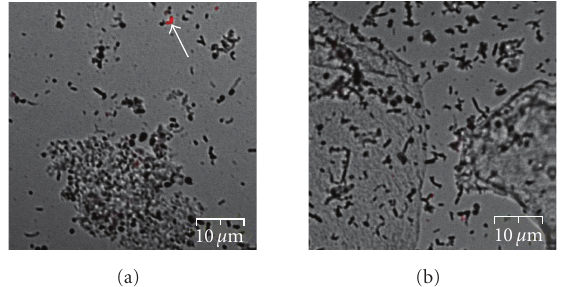
Figure 6: Detection of M. tuberculosis in spiked sputum. M. tuber- culosis spiked sputum and unspiked sputum control were detected with the FNP-IIFM method after pretreatment with the NALC- NaOH method. Both images were overlay of the fluorescence chan- nel and the trasmitted channel of confocal images (60 × oil). (a) Sputum spiked with M. tuberculosis . Note that a bacterium displays bright fluorescence, indicated by the arrow. (b) Unspiked